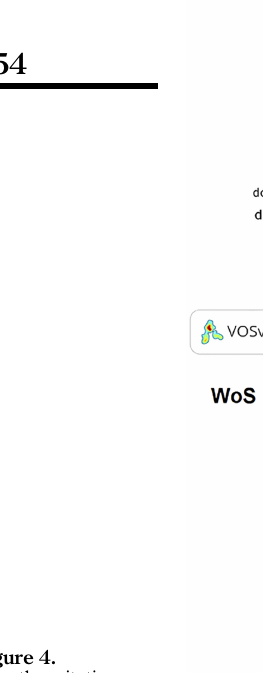
Figure 4. Co-author-citation